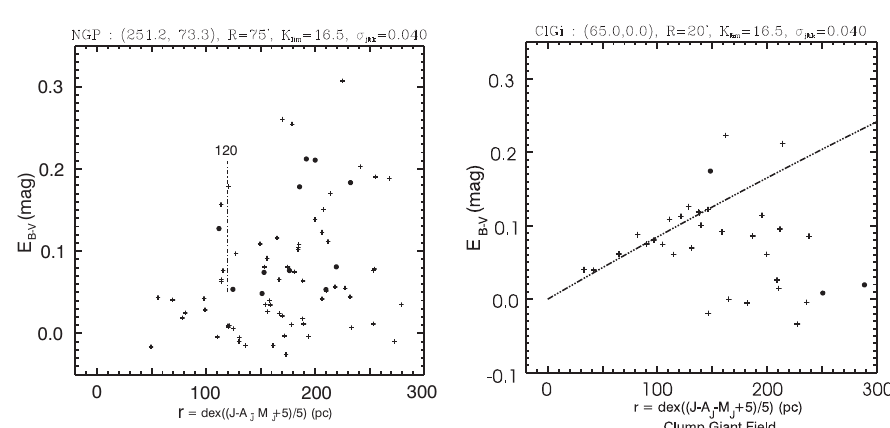
Fig. 3. Color excess vs. distance diagram for the stars within ∼ 300 pc in a high latitude area (left) and a low latitude area (right) validity of the calibrated 2MASS